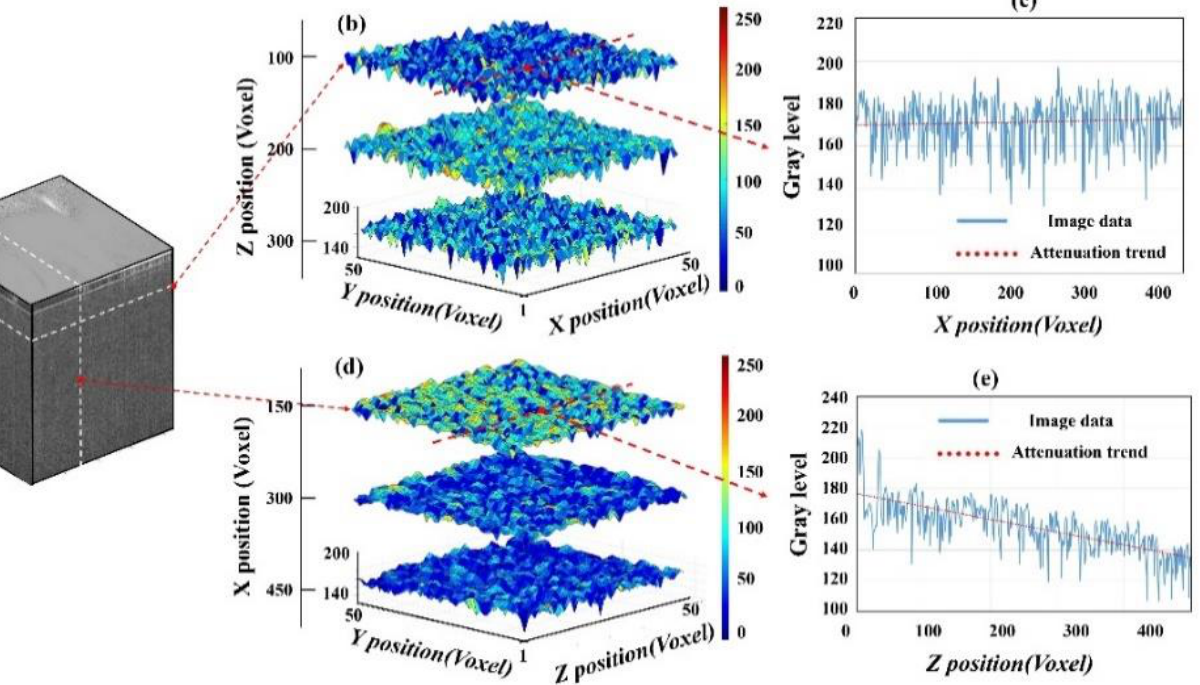
Figure 2. Features of 3D OCT image: ( a ) the 3D image reconstructed by the OCE system; ( b ) the gray level distribution at the positions of 100, 200 and 300 voxels in the axial depth; ( c ) A-Scan image in a cross-section; ( d ) the gray level distribution at the horizontal depth of 150, 300 and 450 voxels; ( e ) A-Scan image on an axial section.